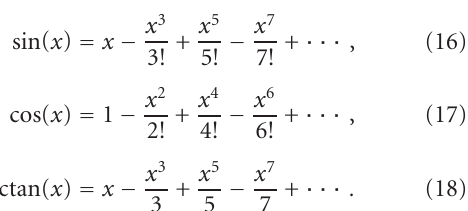
Table 4: Synthesis results. Virtex2 XC2VP30.